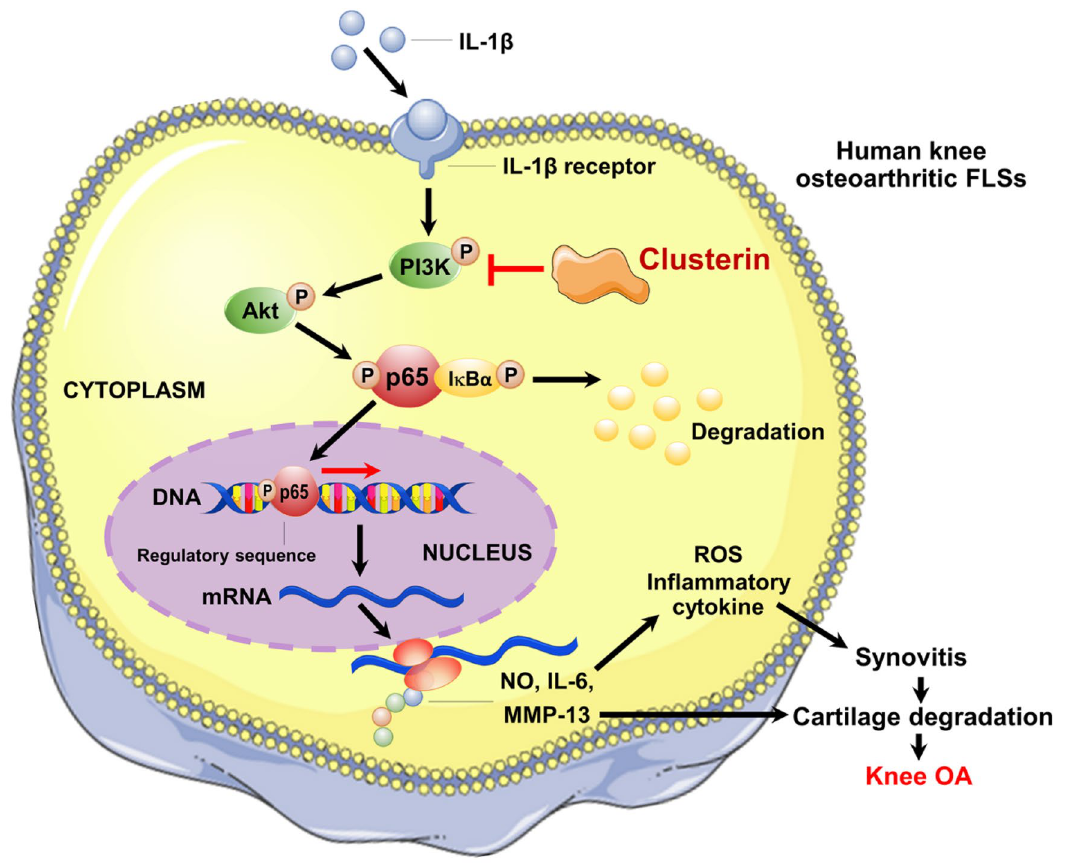
Figure 5. Molecular mechanism underlying anti-inflammatory effect of CLU in knee OA FLSs. CLU has been reported to protect against IL-1β-induced production of ROS, inflammatory cytokine, and cartilage-degrading enzyme in knee OA FLSs through suppressing activation of PI3K/Akt signaling pathway, which may further impede progression of synovitis and subsequent cartilage degradation in knee